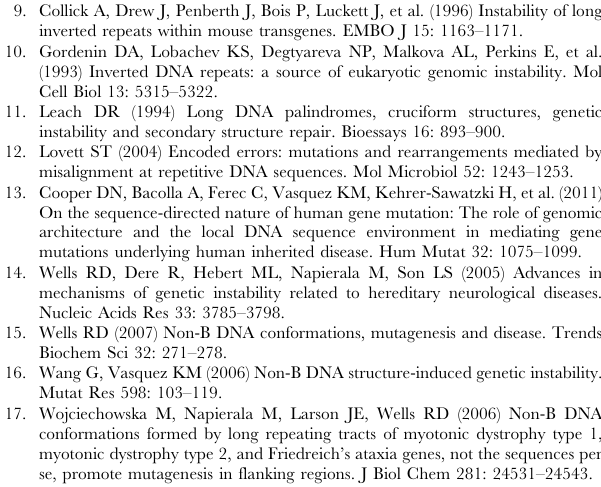
Table S1 Bacterial strains, sources and genetic features. Table S2 List of plasmids, general description, genetic markers and sources/references. Table S3 Primer sequences used for PCR amplification. Table S4 Criteria used for in silico analyses of repetitive elements in bacterial genomes. Table S5 Statistics of in silico searches of repeats